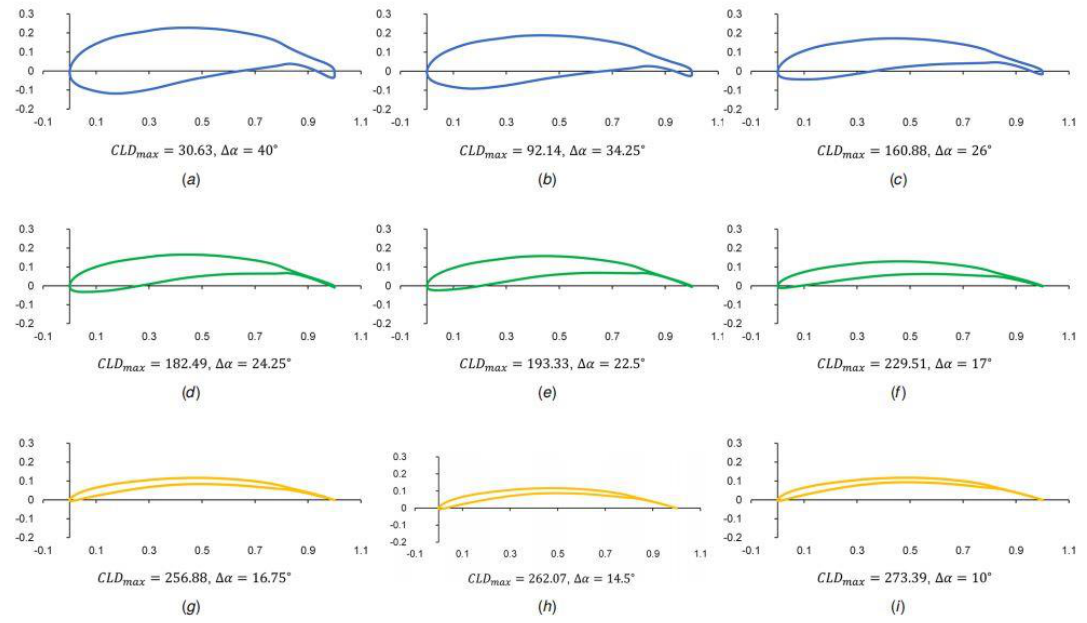
Figure 4. Nine representative Pareto-optimal airfoil shapes ( a – c ) are in cluster 1, ( d – f ) are in cluster 2, and ( g – i ) are in cluster 3